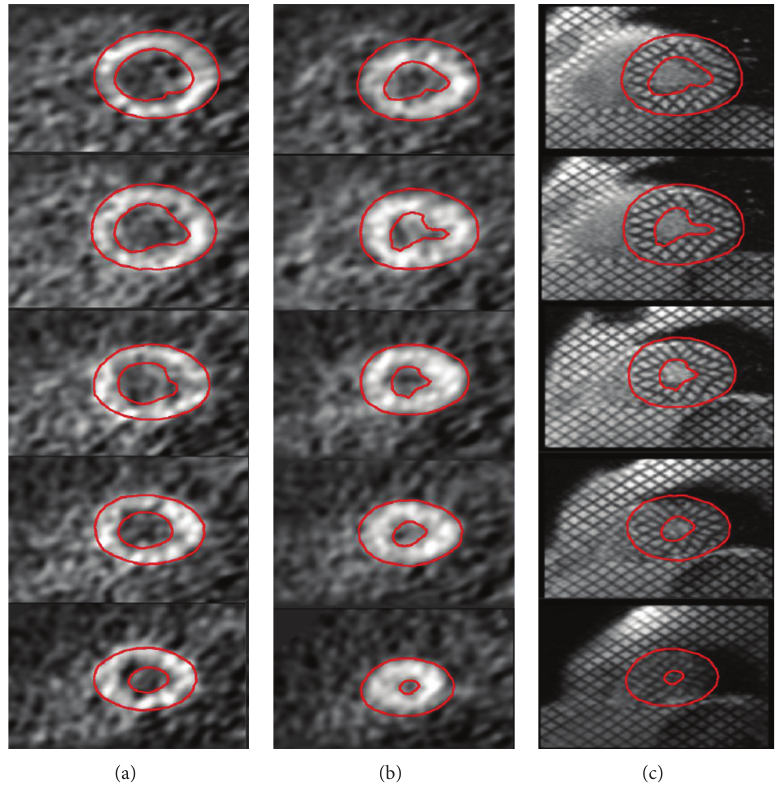
Figure 4: Registration comparison Heart 1. Warping analysis of Heart 1 indicates that excellent image registration was achieved on this image data set. The epi- and endocardial surfaces of the warping model correspond with those surfaces in the higher resolution MRI images on the right (c). (a) End-diastolic images (template) used in the warping analysis, (b) the end-systolic PET (target) images, and (c) the corresponding end-systolic tagged MRI images. Every fourth slice is